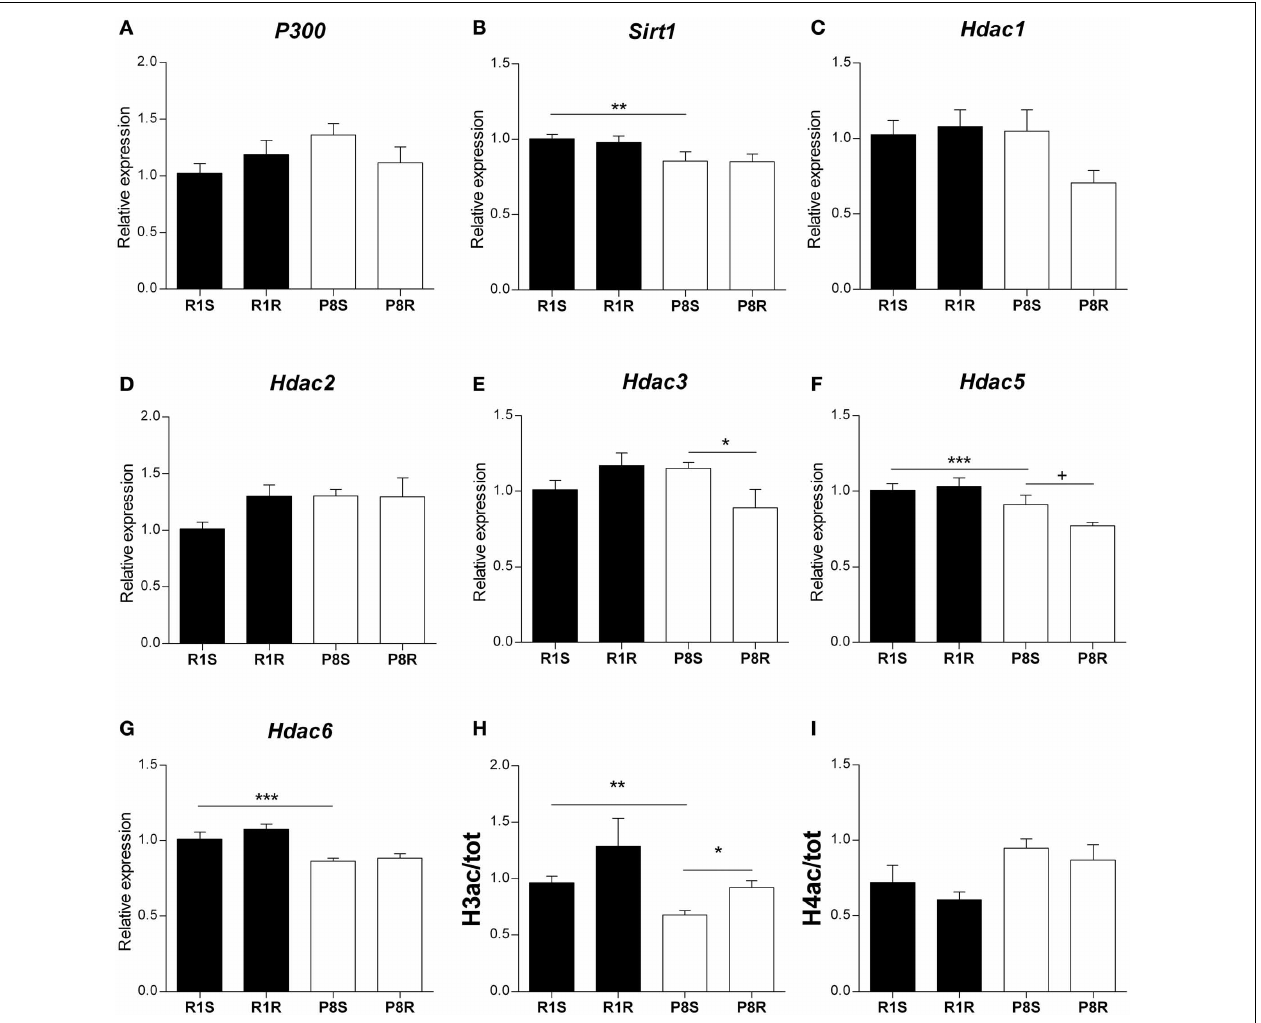
∗ p < 0 . 05; ∗∗ p < 0 . 01; ∗∗∗ p < 0 . 001. (H,I) Global acetylation levels of histone H3 (H) and histone H4 (I) in hippocampus from sedentary and exercised SAMR1 and SAMP8 mice. Specific bands from Western blot were quantified by scanning densitometry ( n = 4/group). Histone modifications were corrected by total histone and results were analyzed by two-tailed Student’s t -test for independent samples. Means ± standard error are represented ( + p < 0 . 1;